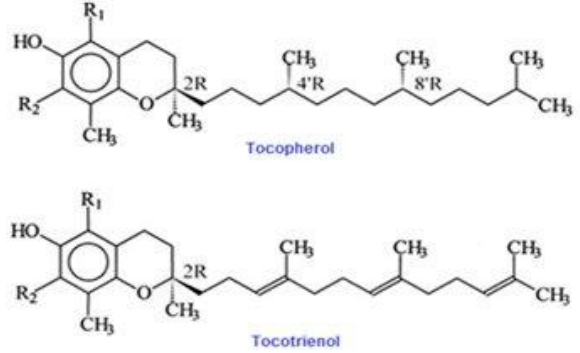
Figure 2: The chemical structure of tocopherols and